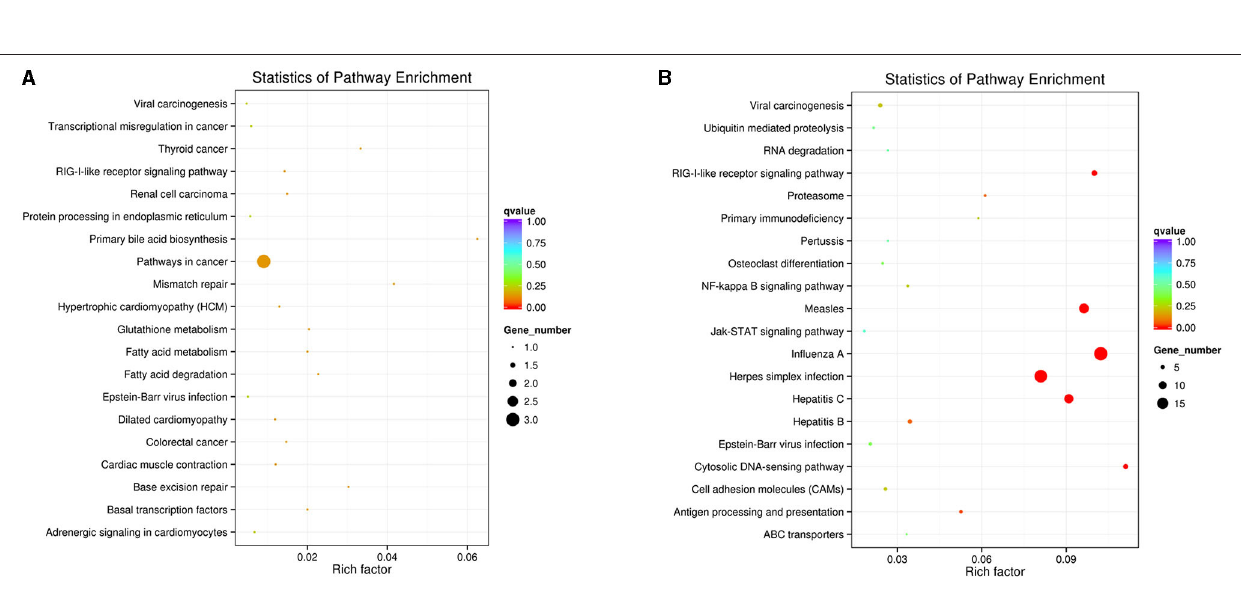
FIGURE 3 | KEGG enrichment analysis of DEGs in the IFNT-treated gEECs. (A) KEGG pathway enrichment analysis of downregulated DEGs. (B) KEGG pathway enrichment analysis of upregulated DEGs. KOBAS software was used to test the statistical enrichment of DEGs in KEGG pathways. P -values were adjusted using Benjamini–Hochberg procedure (adj. p -value <